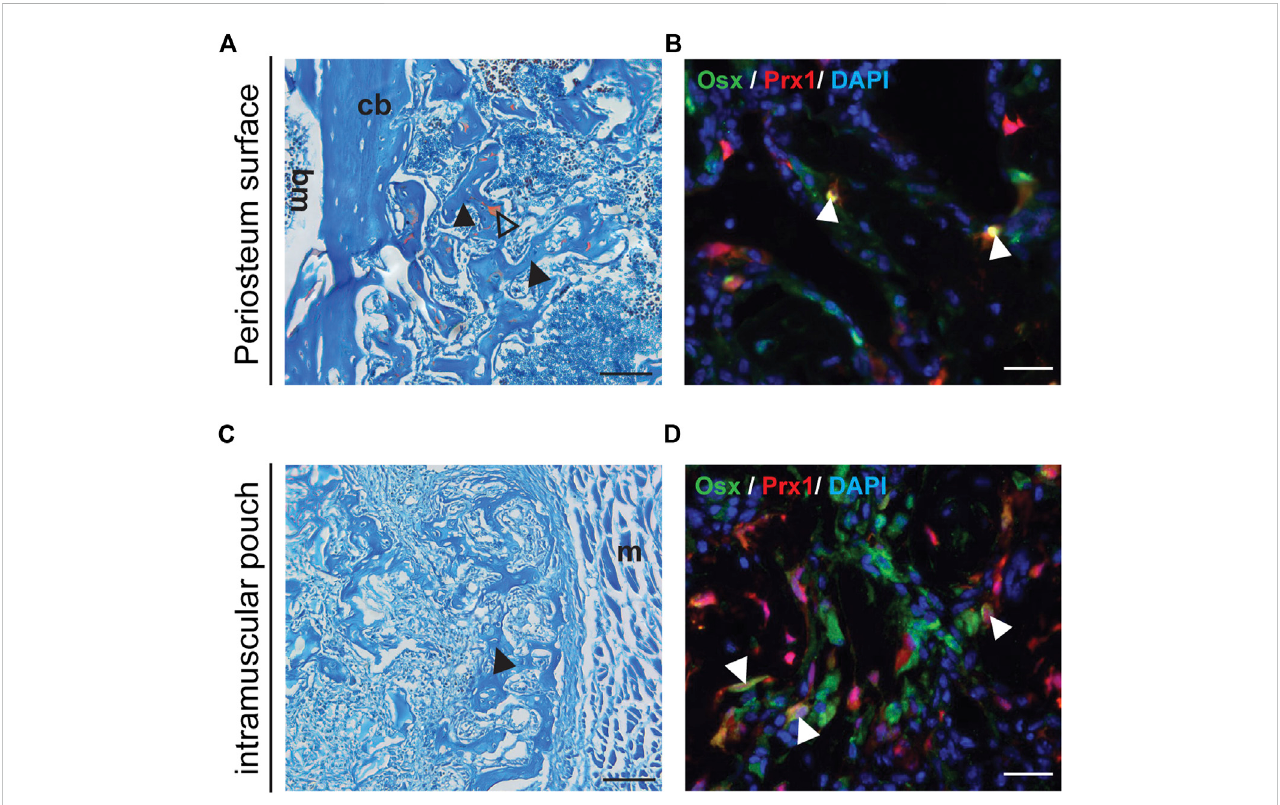
FIGURE 3 Transplanted Muscle-derived cells were able to form bone on periosteal surface and in muscle pouch with 5ug BMP2. Representative Safranin O and IF stainingofthe5 µgBMP2treatedspongewithsurroundingtissueatDay16post-transplantation.SafraninOstaining (A,C) ,theblackarrowheadsindicatebone formation within the sponge, triangle shows cartilage formation. IF staining (B, D) , the white arrowheads indicate co-labeling of Prx1 derived cells (red) with osterix (green), nuclei were labeled with DAPI (blue). (A, B) . Results of muscle cells from Prx1 reporter mice transplanted to the periosteum surface of wild-type hosts. (C, D) . Results of muscle cells from Prx1 reporter mice transplanted to the muscle pouch of wild-type hosts. Scale bar = 100 μ m for Safranin O, 25 µm for IF staining; bm, bone marrow; cb, cortical bone; m, muscle. Images are representative of 3 independent